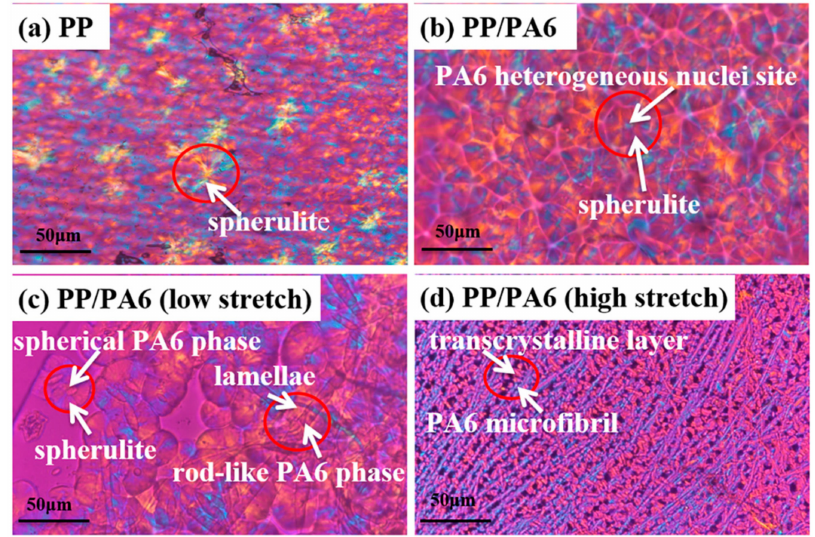
Figure 6. Polarizing optical microscopy (POM) micrographs of ( a ) pure PP, ( b ) PP / PA6 blends, ( c ) PP / PA6 blends with low stretch and ( d ) PP / PA6 blends with high